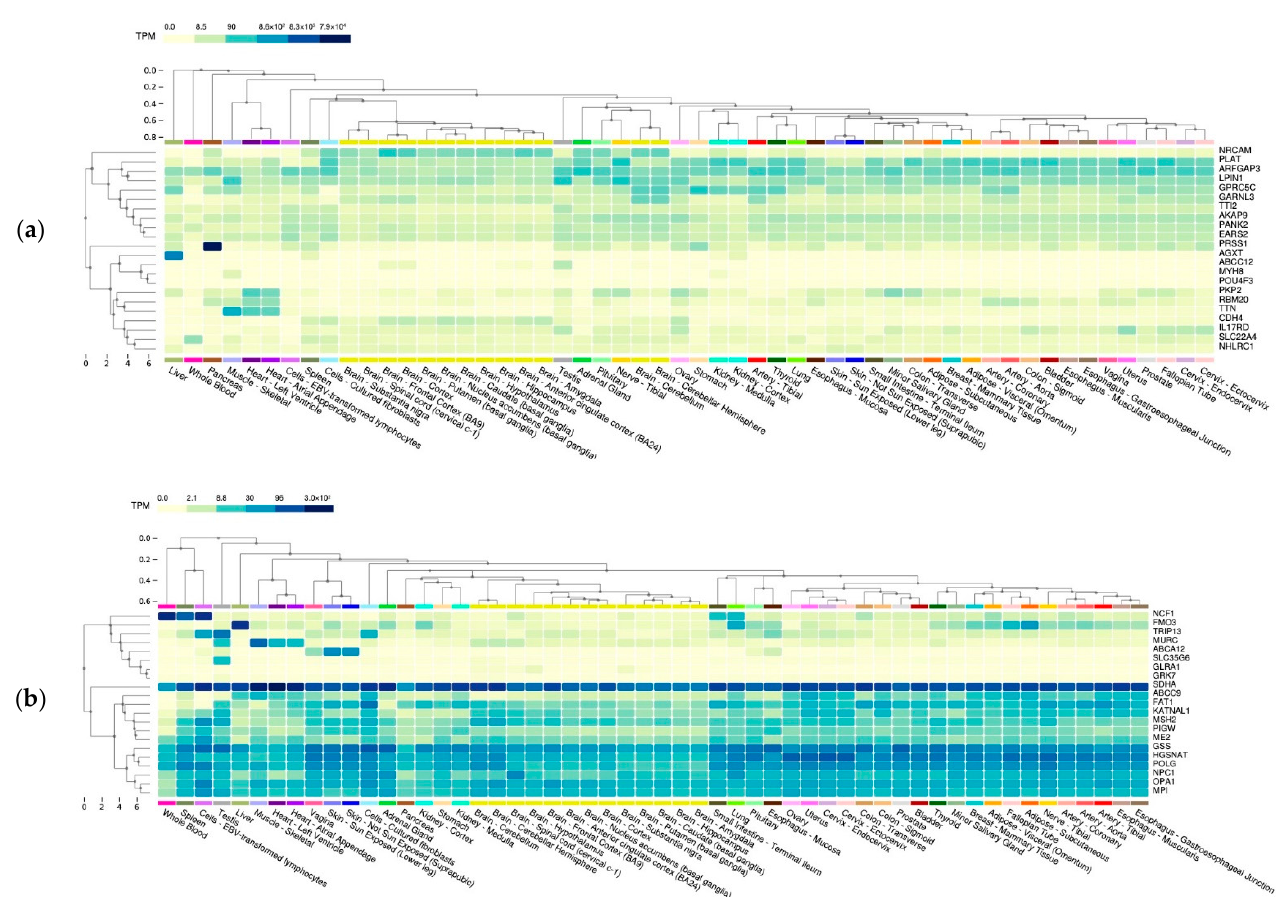
Figure 3. ( a ) Expression of MFS pt.2 candidate genes among all tissues.; ( b ) Expression of MFS pt.5 candidate genes among all tissues.